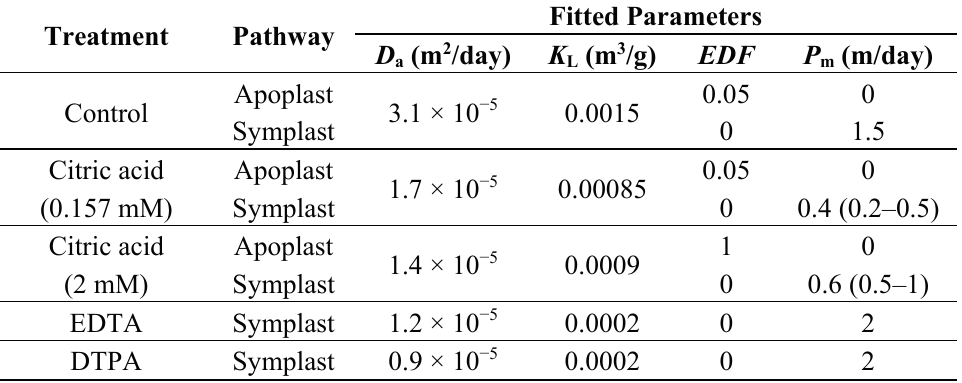
Table 1. Values of sensitive parameters for apoplastic diffusion ( D a ), sorption ( K L ), endodermal damage ( EDF ) and membrane permeability ( P m ) calibrated with experimental data. For the uptake of Cu in Control and Citric acid treatments, both apoplastic and symplastic pathways are possible, while EDTA and DTPA treatments require symplastic